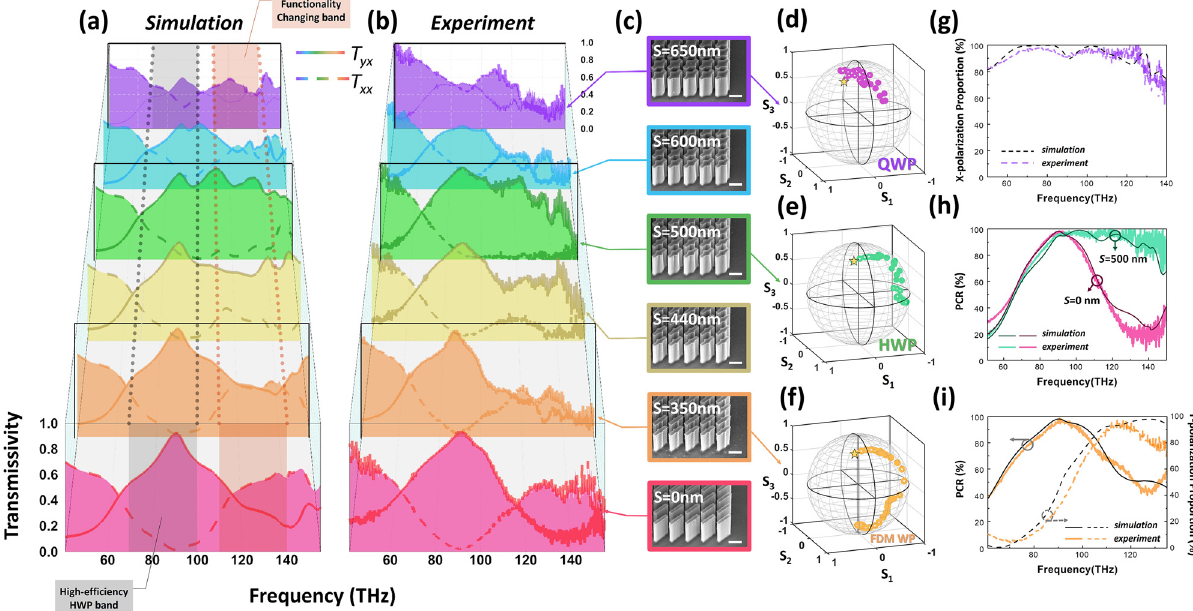
Figure 2: Polarization manipulation performance of different CNs. (a)and(b)NumericalsimulatedandexperimentallymeasuredintensitytransmissivityspectraofdifferentCNmetasurfaces.(c)SEMimagesof CN metasurfaces with s varies from 0 to 650 nm. (d) – (f) Poincaré spheres of output light for x -polarized input of CN when s = 650, 500 and 350 nm. (g) Simulated (black dash curve) and measured (violet dash curve) proportion of y-polarized light in the transmitted fi eld when s = 650 nm. (h) Simulated and measured PCR of CN when s = 0 nm (dark red and light red curves) and s = 500 nm (dark green and light green curves). (i) Simulated (black curves) and measured (orange curves) PCR (solid line) and proportion of y -polarized light in the transmitted fi eld (dash line) when s = 350